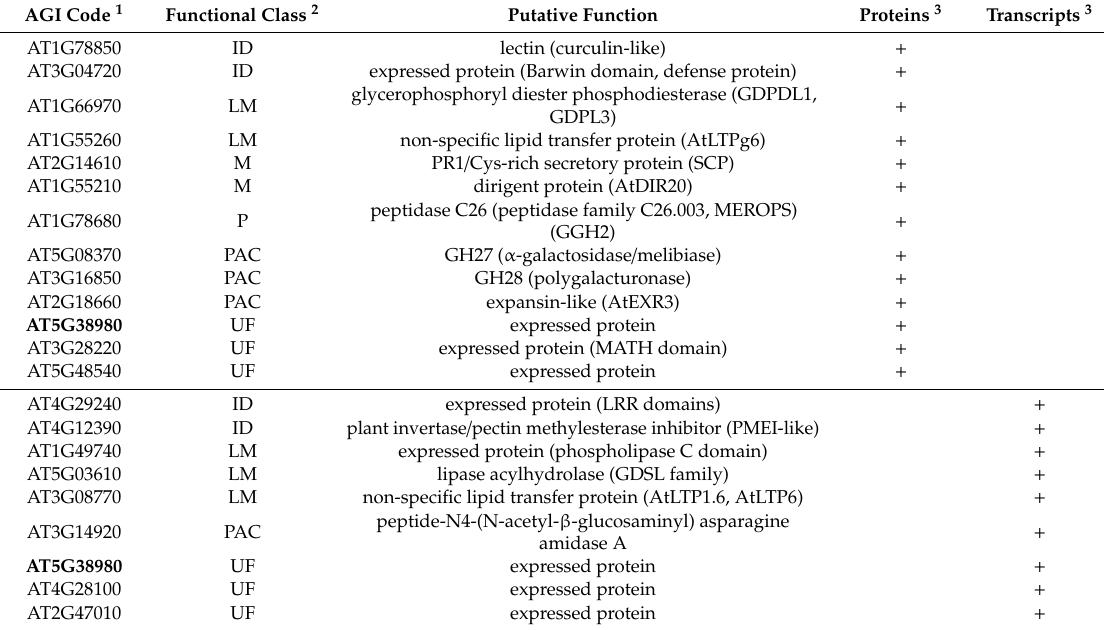
Table 4. Synopsis of CWPs or CW transcripts di ff erentially accumulated at a given growth temperature in floral